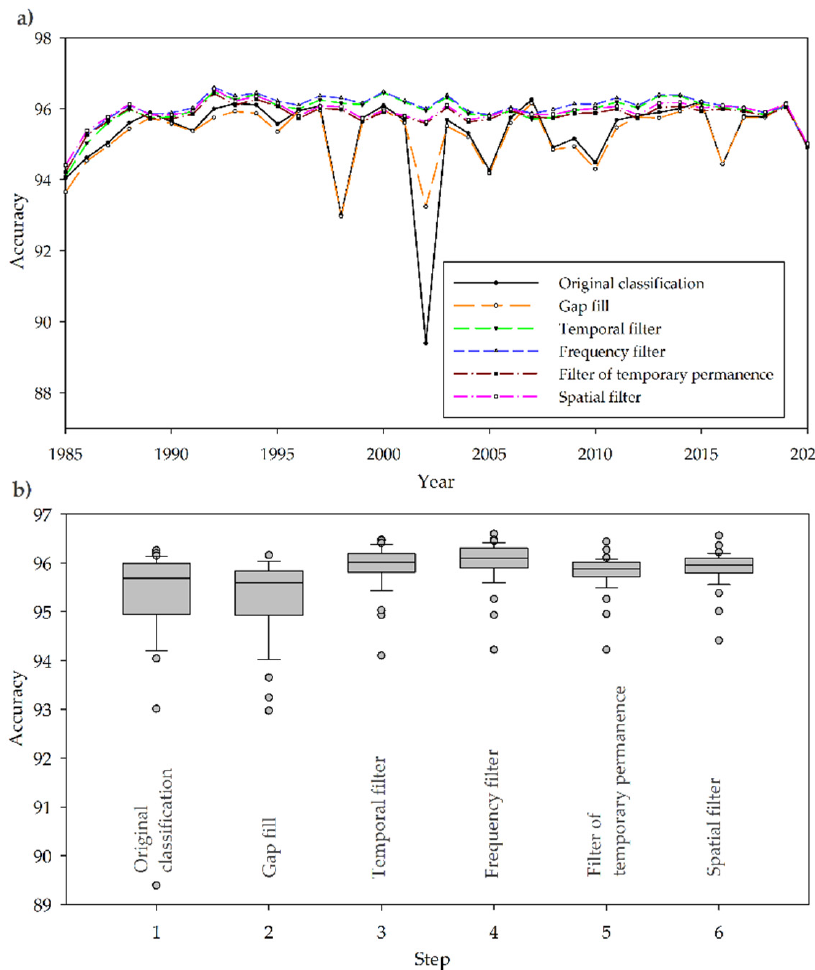
Figure 15. Accuracy after filter application ( a ) multiannual accuracy plot, and ( b ) accuracy box plot for the cumulative sequential use of temporal filters.